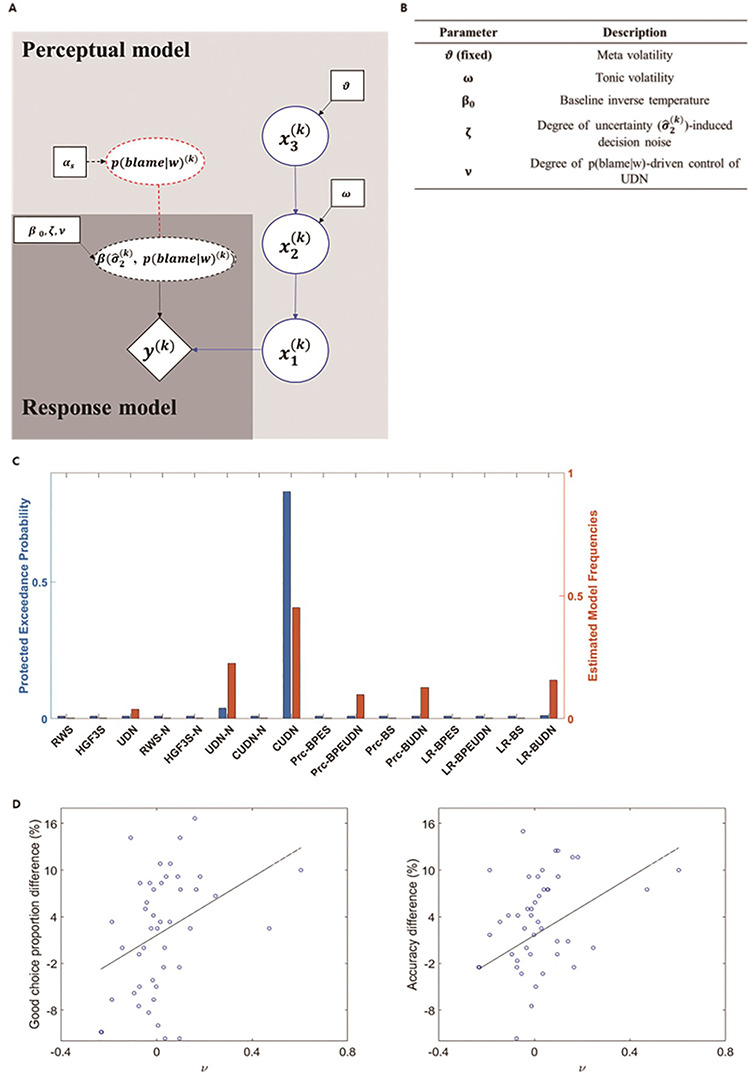
(A) Graphic description of the computational model of behavioural optimization under the expectation of being blamed. The CUDN model was composed of the following parts: the perceptual model and response model. The perceptual model is composed of two parallel learning systems—learning p(correct|cue) by the three-level hierarchical Gaussian filter (HGF) model (blue) and learning p(blame|w) by the Rescorla–Wagner (RW) model (red dashed circle). Importantly, in the response model, \documentclass[12pt]{minimal}
\usepackage{amsmath}
\usepackage{wasysym}
\usepackage{amsfonts}
\usepackage{amssymb}
\usepackage{amsbsy}
\usepackage{upgreek}
\usepackage{mathrsfs}
\setlength{\oddsidemargin}{-69pt}
\begin{document}
}{}${y^{\left( k \right)}}$\end{document} represents a choice at trial k, and the \documentclass[12pt]{minimal}
\usepackage{amsmath}
\usepackage{wasysym}
\usepackage{amsfonts}
\usepackage{amssymb}
\usepackage{amsbsy}
\usepackage{upgreek}
\usepackage{mathrsfs}
\setlength{\oddsidemargin}{-69pt}
\begin{document}
}{}$\beta $\end{document}, which is the inverse temperature of the Softmax function, is a function of an estimation uncertainty \documentclass[12pt]{minimal}
\usepackage{amsmath}
\usepackage{wasysym}
\usepackage{amsfonts}
\usepackage{amssymb}
\usepackage{amsbsy}
\usepackage{upgreek}
\usepackage{mathrsfs}
\setlength{\oddsidemargin}{-69pt}
\begin{document}
}{}$(\hat \sigma _2^{\left( k \right)})$\end{document} and \documentclass[12pt]{minimal}
\usepackage{amsmath}
\usepackage{wasysym}
\usepackage{amsfonts}
\usepackage{amssymb}
\usepackage{amsbsy}
\usepackage{upgreek}
\usepackage{mathrsfs}
\setlength{\oddsidemargin}{-69pt}
\begin{document}
}{}$ p{(blame|w)^{\left( k \right)}}$\end{document} such that \documentclass[12pt]{minimal}
\usepackage{amsmath}
\usepackage{wasysym}
\usepackage{amsfonts}
\usepackage{amssymb}
\usepackage{amsbsy}
\usepackage{upgreek}
\usepackage{mathrsfs}
\setlength{\oddsidemargin}{-69pt}
\begin{document}
}{}$\hat \sigma _2^{\left( k \right)}$\end{document} induces decision noise and \documentclass[12pt]{minimal}
\usepackage{amsmath}
\usepackage{wasysym}
\usepackage{amsfonts}
\usepackage{amssymb}
\usepackage{amsbsy}
\usepackage{upgreek}
\usepackage{mathrsfs}
\setlength{\oddsidemargin}{-69pt}
\begin{document}
}{}$ p{(blame|w)^{\left( k \right)}}$\end{document} suppresses UDN. In this graphic representation, a deterministic node and relationship are represented as dashed circles and dashed lines, respectively, while solid circles and lines represent a stochastic node and relationship. (B) Parameters of the CUDN model. In the function \documentclass[12pt]{minimal}
\usepackage{amsmath}
\usepackage{wasysym}
\usepackage{amsfonts}
\usepackage{amssymb}
\usepackage{amsbsy}
\usepackage{upgreek}
\usepackage{mathrsfs}
\setlength{\oddsidemargin}{-69pt}
\begin{document}
}{}$\beta \left( {\hat \sigma _2^{\left( k \right)}, p{{(blame|w)}^{\left( k \right)}}} \right)$\end{document}, parameter \documentclass[12pt]{minimal}
\usepackage{amsmath}
\usepackage{wasysym}
\usepackage{amsfonts}
\usepackage{amssymb}
\usepackage{amsbsy}
\usepackage{upgreek}
\usepackage{mathrsfs}
\setlength{\oddsidemargin}{-69pt}
\begin{document}
}{}$\zeta $\end{document} determines the participants’ degree of UDN, and \documentclass[12pt]{minimal}
\usepackage{amsmath}
\usepackage{wasysym}
\usepackage{amsfonts}
\usepackage{amssymb}
\usepackage{amsbsy}
\usepackage{upgreek}
\usepackage{mathrsfs}
\setlength{\oddsidemargin}{-69pt}
\begin{document}
}{}$\nu $\end{document} determines the participants’ degree of suppression on UDN as p(blame|w) increases. (C) Bayesian model selection results. The results of the RFX-BMS show that the CUDN model fits the participants’ behaviour better than other models (PEP = 0.831). (D) Correlation between \documentclass[12pt]{minimal}
\usepackage{amsmath}
\usepackage{wasysym}
\usepackage{amsfonts}
\usepackage{amssymb}
\usepackage{amsbsy}
\usepackage{upgreek}
\usepackage{mathrsfs}
\setlength{\oddsidemargin}{-69pt}
\begin{document}
}{}${\bf{\it{\nu }}}$\end{document} and good choice/accuracy enhancement. The results of correlation analysis showed that the participants with large \documentclass[12pt]{minimal}
\usepackage{amsmath}
\usepackage{wasysym}
\usepackage{amsfonts}
\usepackage{amssymb}
\usepackage{amsbsy}
\usepackage{upgreek}
\usepackage{mathrsfs}
\setlength{\oddsidemargin}{-69pt}
\begin{document}
}{}$\nu $\end{document} showed enhanced good choice proportion (left) and accuracy (right) in high-blame blocks. Note that these significant correlations also existed after removing points with values outside of 2 s.d. (rightmost 2 points) from the mean (all P < 0.05).